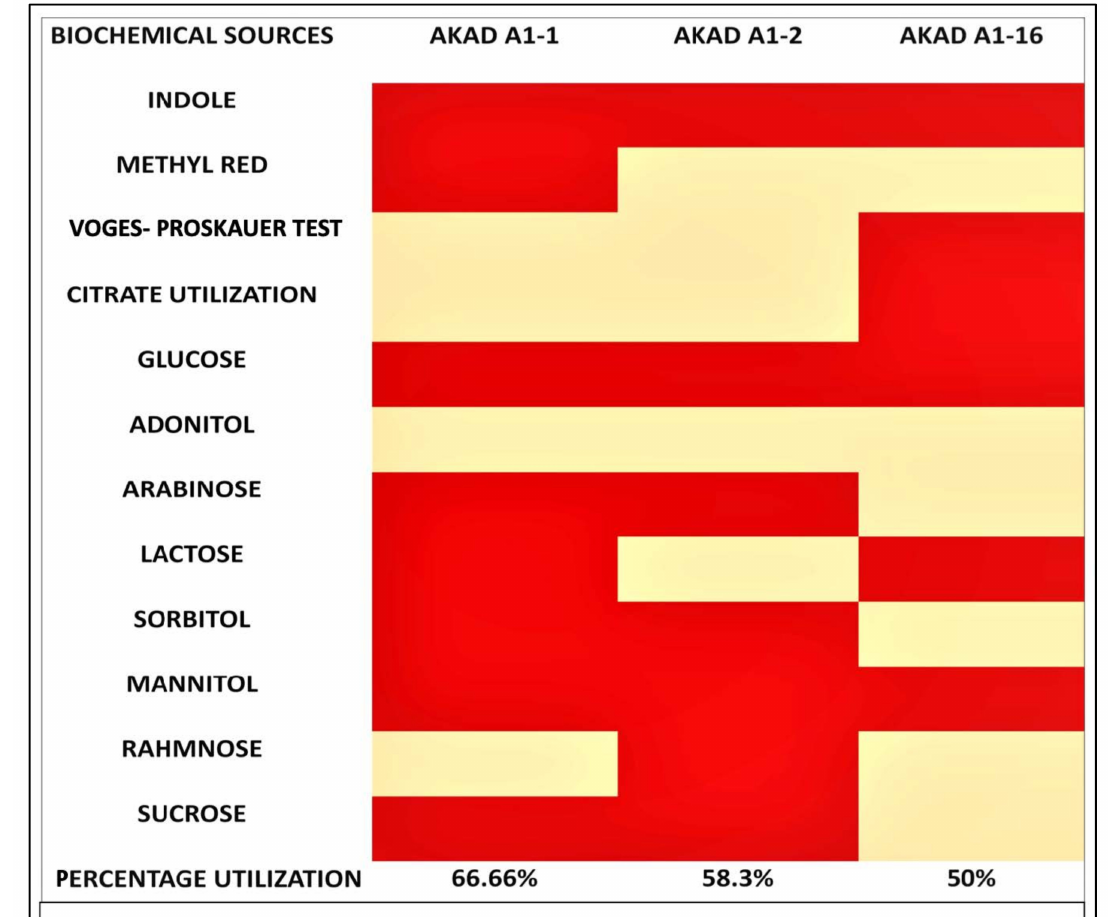
Figure 3. Biochemical source utilization by endophytic bacterial